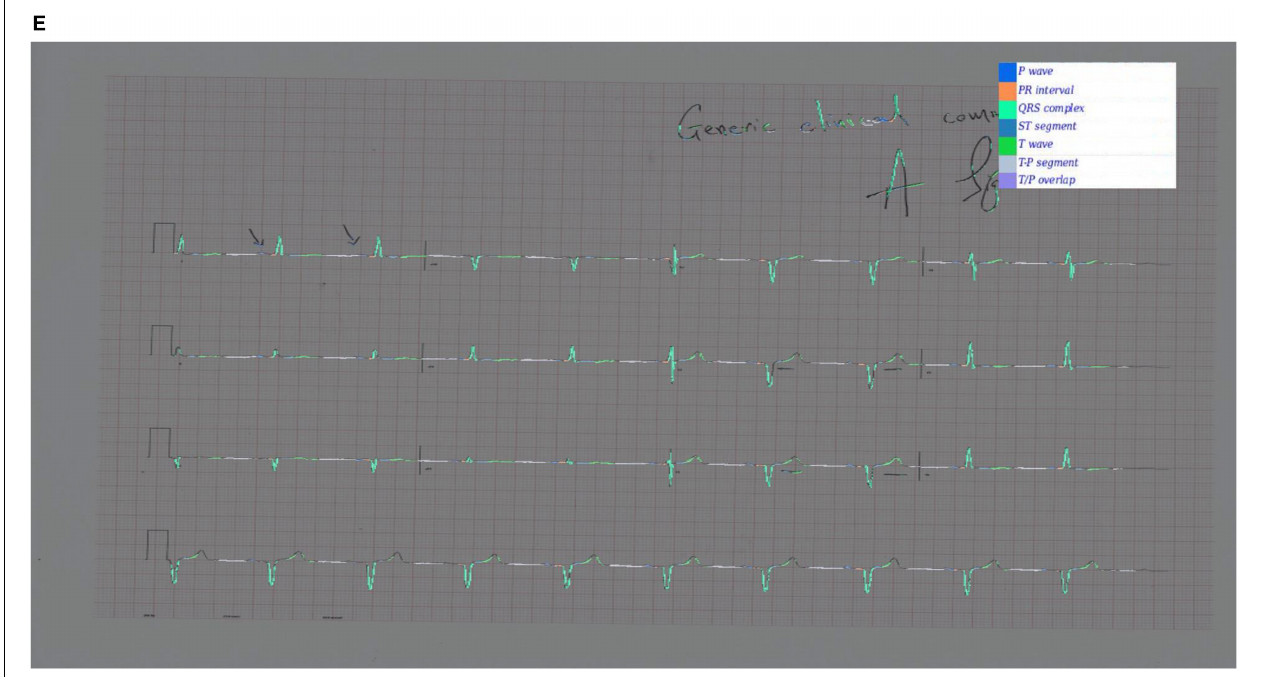
FIGURE 5 | (A) A segmentation mask for a randomly selected ECG signal from the PTB database. This mask was predicted for the raw ECG signal using a 1D U-Net. Both the raw signal and the segmentation mask were subsequently plotted into an image file. The model that predicted this mask was pretrained exclusively on synthetic ECG signals. (B) Segmentation mask for a randomly selected PTB signal that was (i) plotted into an ECG image using the software developed for this experiment; (ii) printed using a standard desktop printer (HP Envy 4520 series); photographed using a Samsung Galaxy S10 mobile phone (flash off, bright